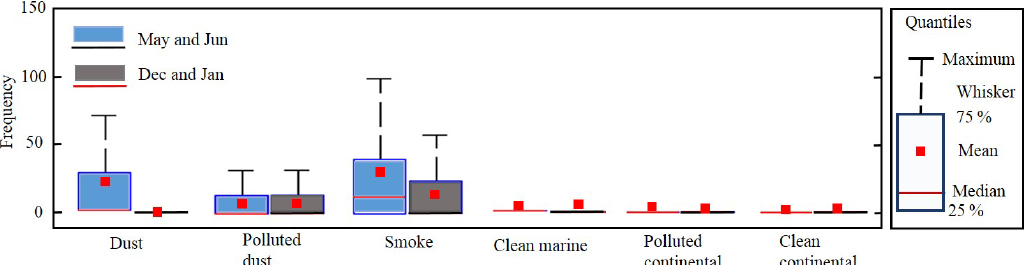
Figure 2. Frequency distribution of aerosol subtypes in the atmosphere over the study region calculated from CALIPSO data; average for the study months in 2006 to